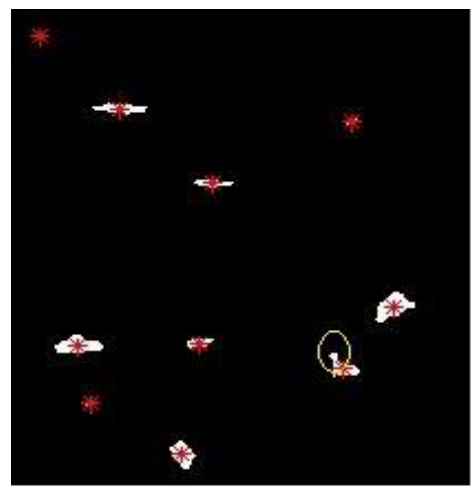
Fig. 4 ALOS PALSAR -1 sub-image A output